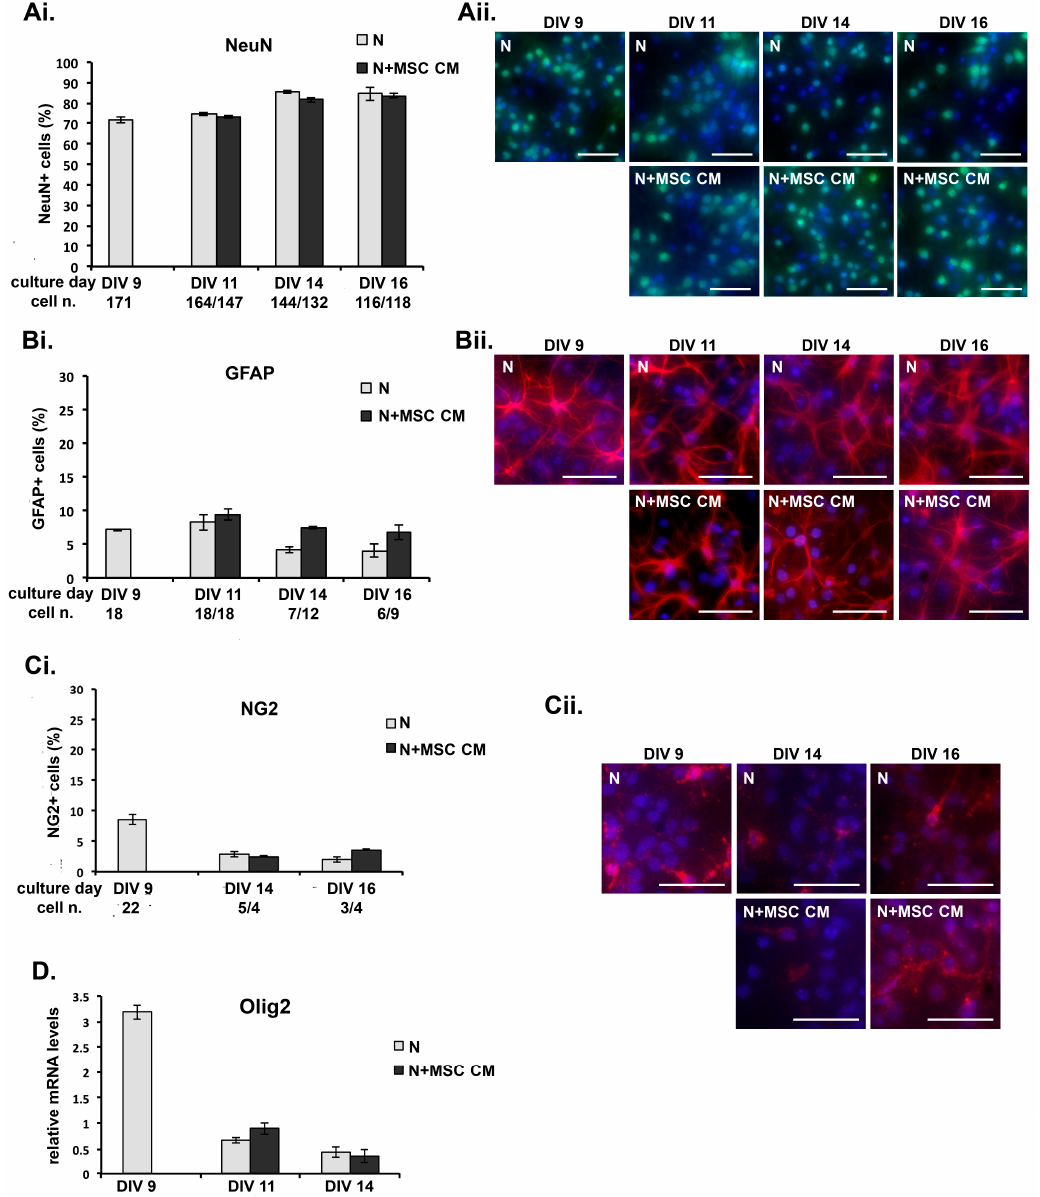
Figure 3. MSC secreted factors do not induce differential survival of neurons or expansion of non-neuronal cells in long-term cultures. ( A – C ) DIV 9 cortical neurons were grown in MSC CM for different lengths of time, fixed and immunostained using antibodies for cell markers, ( A ) neuronal nuclei (NeuN) for neurons, ( B ) glial fibrillary acidic protein (GFAP) for mature astrocytes and new neurons, and ( C ) neural/glial antigen 2 (NG2) for oligodendrocyte precursor cells (OPC), microglia/macrophages and pericytes, and nuclei counterstained with the fluorescent DNA stain 4 ′ ,6-diamidino-2-phenylindole (DAPI). The proportions of each cell type (percentage of specifically-immunostained cells compared to total numbers of DAPI-stained cells) in the untreated and MSC CM-treated cultures at each time point are shown ( Ai , Bi , Ci ). The total numbers of DAPI-stained cells/field in cultures at each time point and condition are shown under the x -axis. Representative fields from each culture are shown in photographs ( Aii , Bii , Cii ). Scale bars 100 µ M. ( D ) DIV 9 cortical neurons were grown in MSC CM for different lengths of time, and levels of mRNA for Olig2 measured by quantitative PCR. Results shown are means ± SEM of triplicate samples from one representative of three independent experiments. p > 0.05 for pairwise comparisons by Student’s t -test.